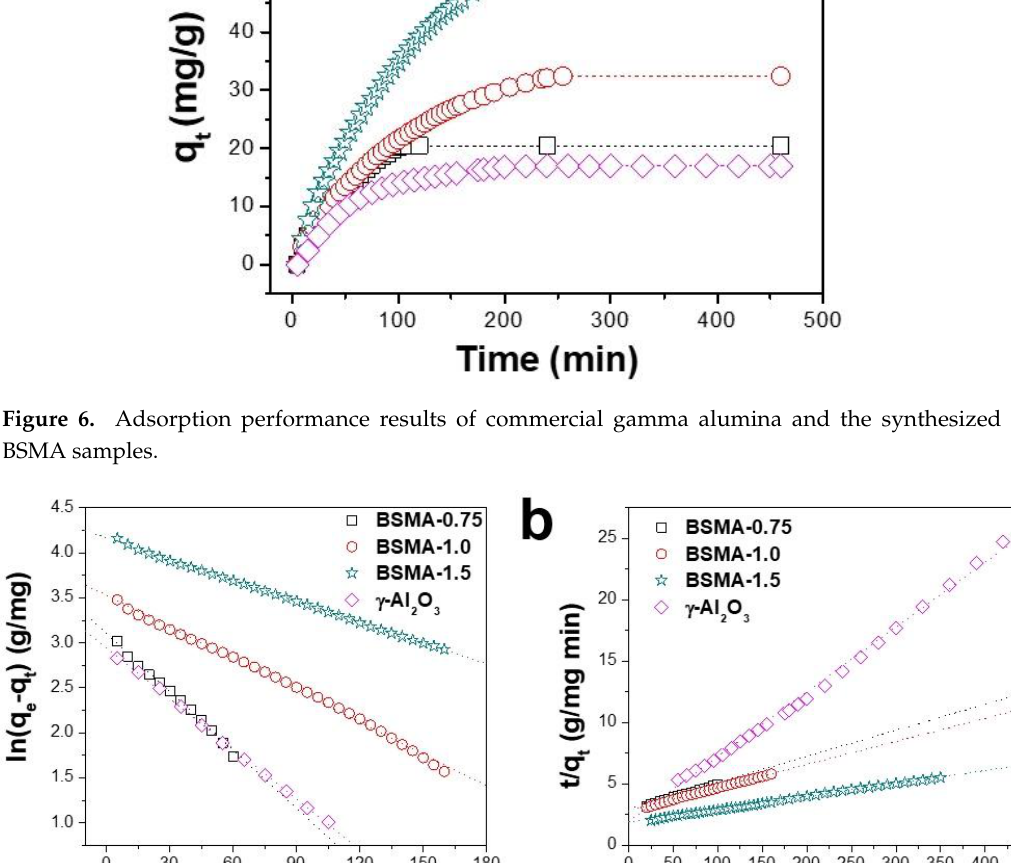
Figure 6. Adsorption performance results of commercial gamma alumina and the synthesized BSMA samples.